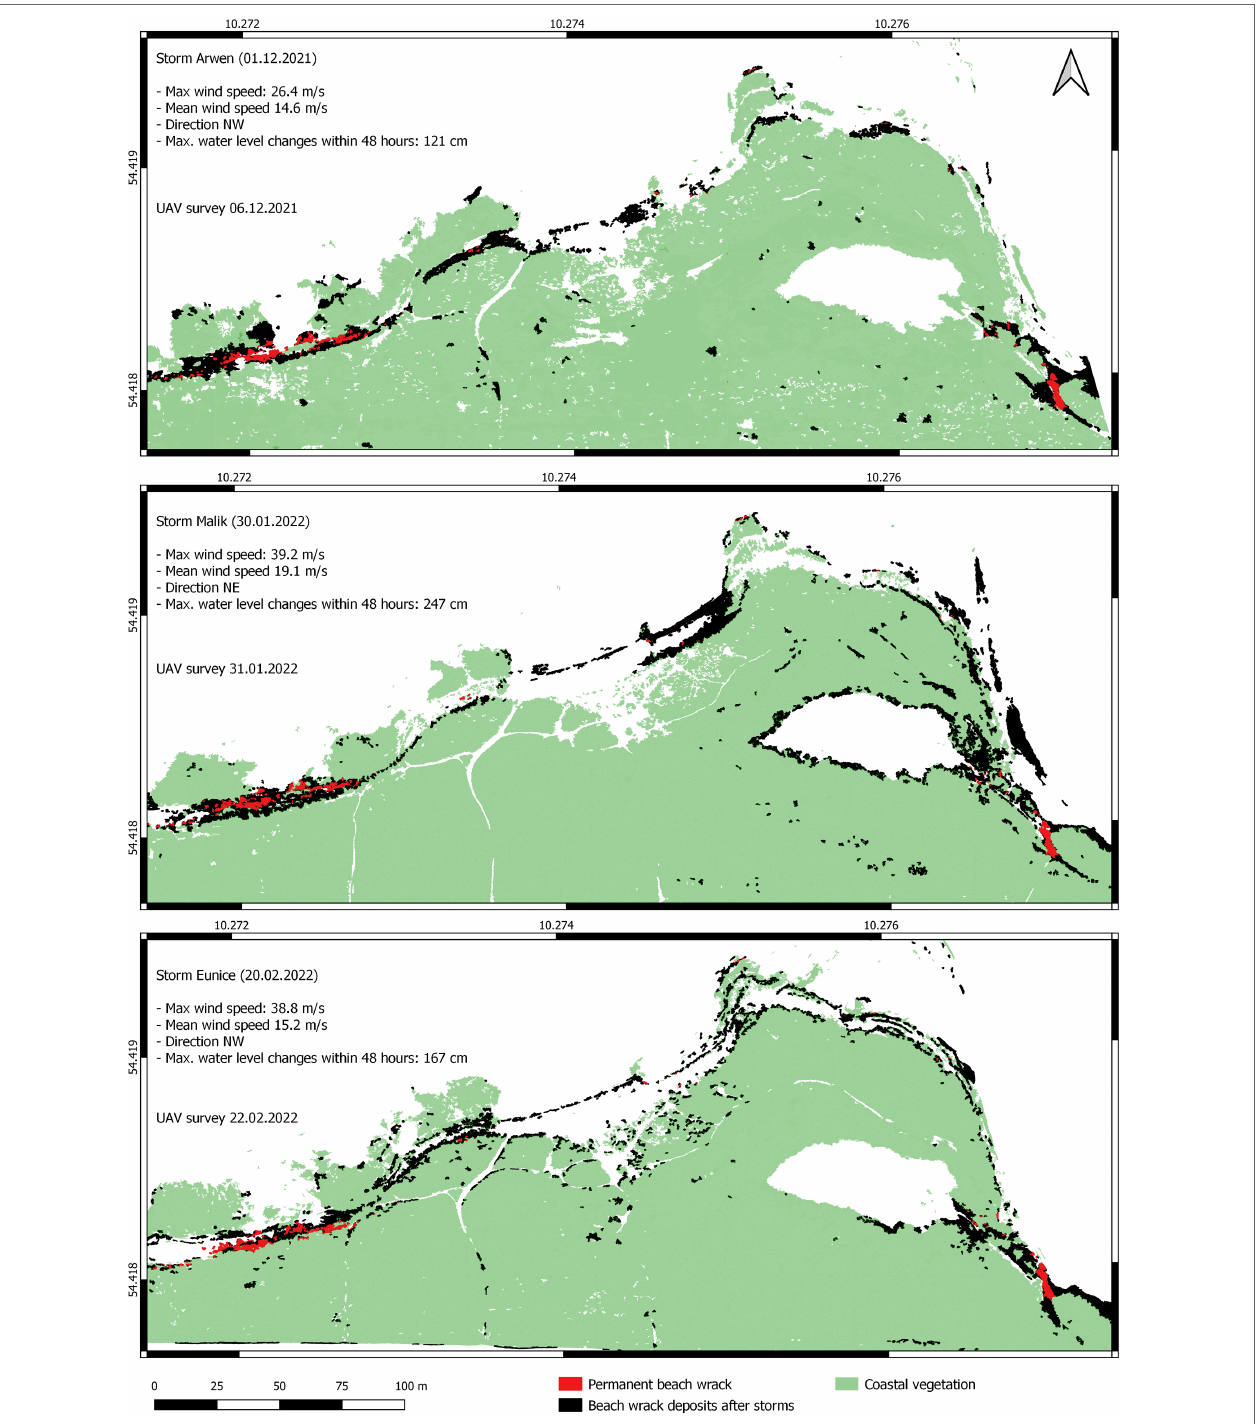
FIGURE 5 | Beach wrack deposits after Storm Arwen in December 2021, Storm Malik in January 2022, and Storm Eunice in February 2022. Marked in red are the areas with permanent beach wrack during the winter storm season